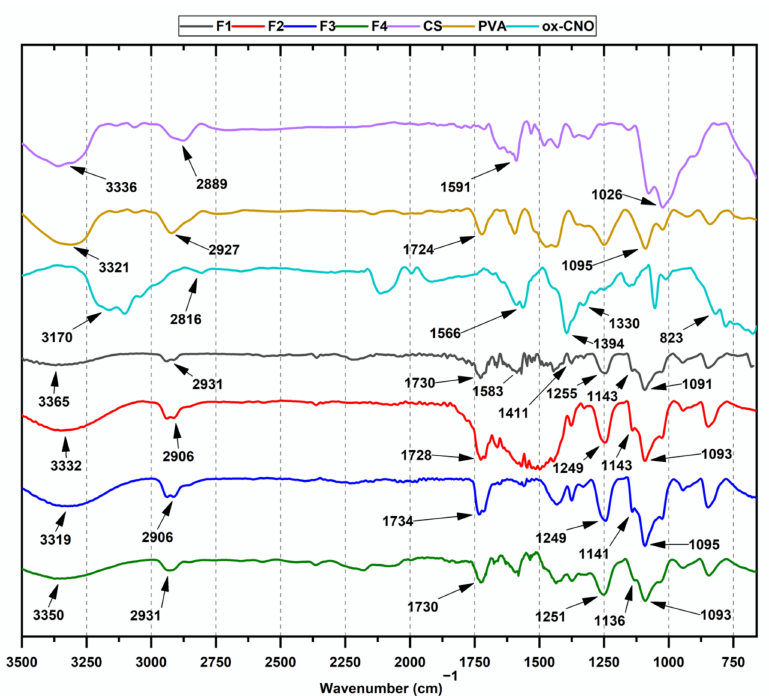
Figure 1. Attenuated total reflectance Fourier-transform infrared spectroscopy (ATR-FT-IR) of elec- trospun CS/PVA/ox-CNO composite nanofibrous membranes: F1 (CS:PVA:ox-CNO 8:92:0); F2 (CS:PVA:ox-CNO 8:91:1); F3 (CS:PVA:ox-CNO 3.5:95.5:1); F4 (CS:PVA:ox-CNO